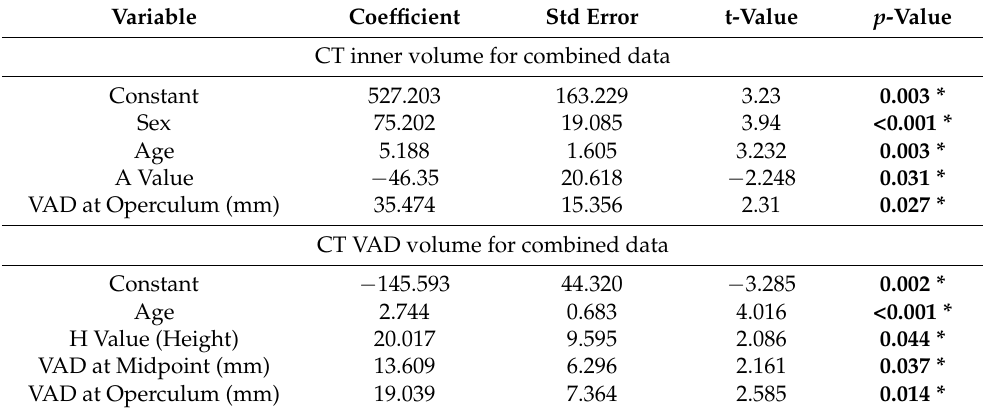
Table 2. Regression analysis of factors predicting CT inner volume and CT VAD volume.